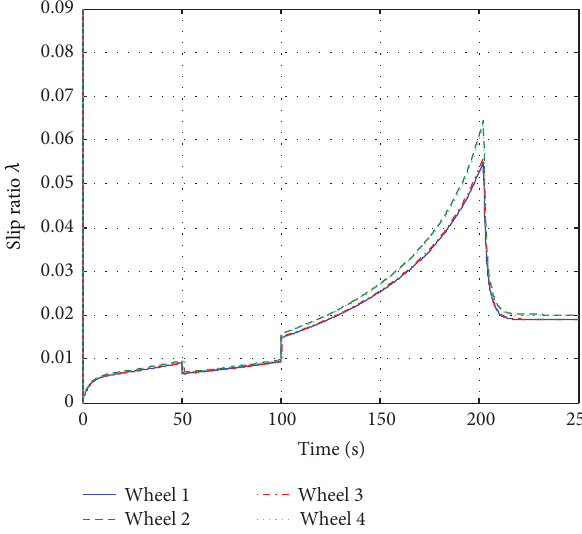
Figure 7: Performance of tracking position error.